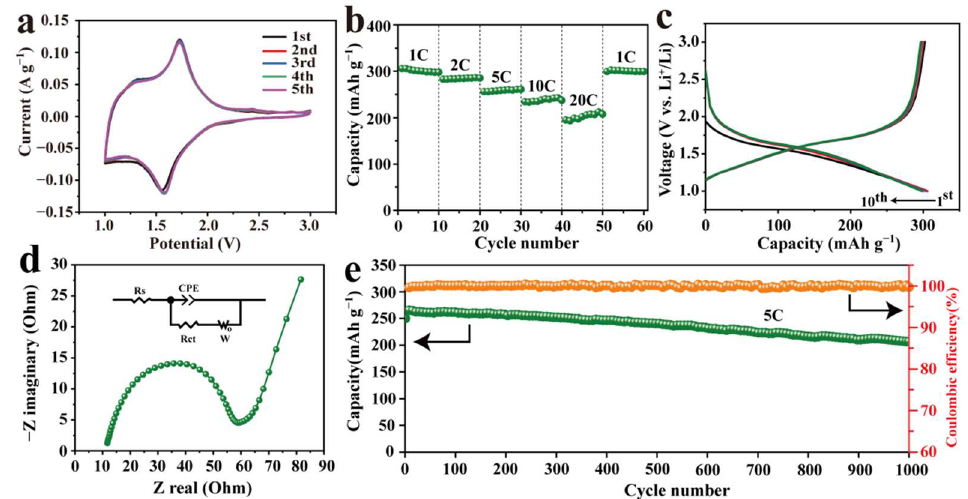
Figure 3. ( a ) Initial five CV curves of TNO@C at a 0.1 mV s − 1 scan rate; ( b ) the rate performance of TNO@C; ( c ) constant current discharge/charge curve of the ten initial cycles of TNO@C at 1 C; ( d ) Nyquist plot of the TNO@C electrode; ( e ) plot of discharge capacity versus cycle number.